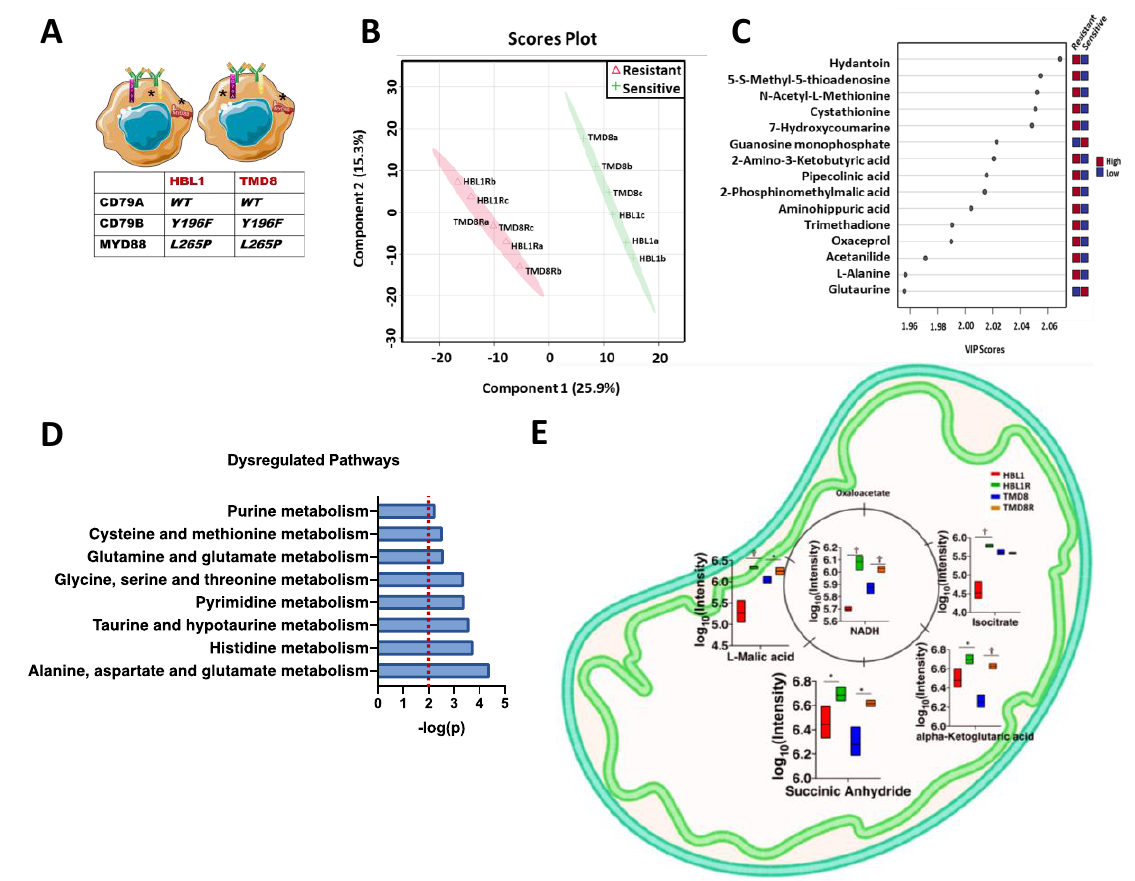
Figure 1. Metabolic profiling of the ibrutinib-resistant ABC-DLBCLs (HBL-1 and TMD-8). ( A ) Wild--type HBL1 and TMD8 cells were selected for their B cell receptor (BCR) independence and MYD88 gene expression (exhibiting mutation in CD79B (Y196F) and MYD88 (L265P). ( B ) PLS-DA plot depicting the variability in metabolic profiles of sensitive (HBL-1 and TMD-8) versus its resistant clone (HBL-1R and TMD-8R). ( C ) VIP plot showing the metabolites driving separation of the uniqueness in metabolic profiles. ( D ) Pathway analysis revealing the top significantly dysregulated metabolic pathways across the two phenotypes, based on -log(p) cutoff of 2 and pathway impact >0.2 depicted by dashed red line. ( E ) TCA cycle metabolites enrichment in sensitive vs resistant phenotype showing increased oxidative phosphorylation. The metabolites are represented as log 10 intensity and unpaired students t-test was used for statistical analysis ( p < 0.05).